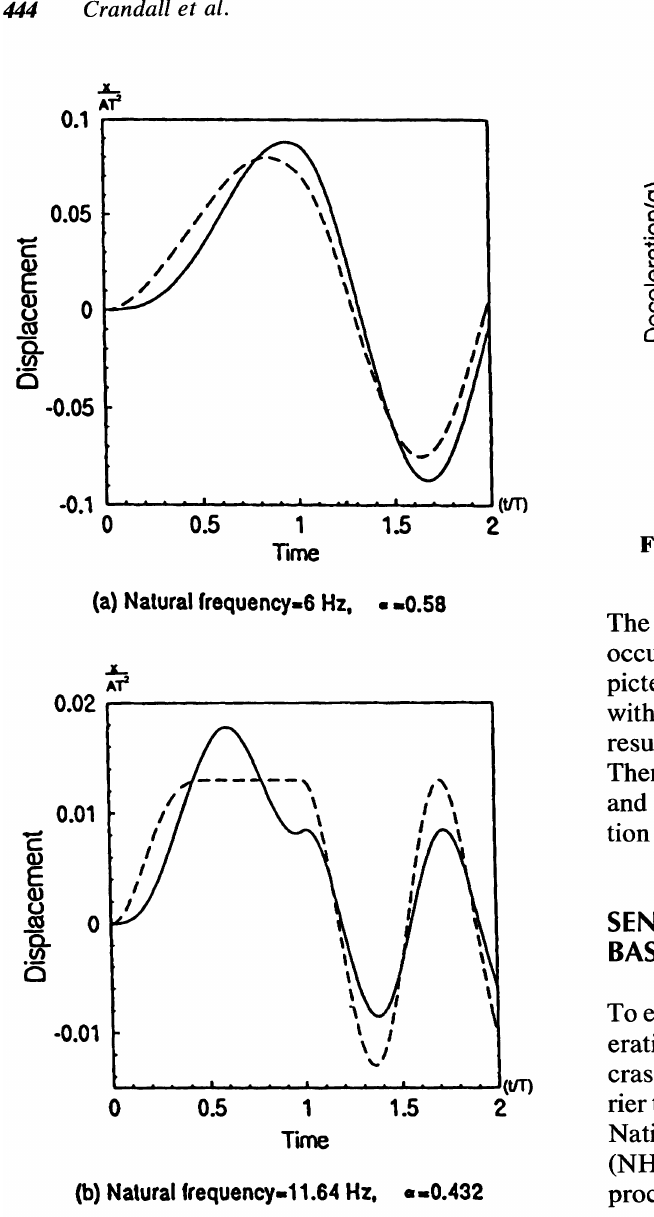
FIGURE 13 Responses of a single degree offreedom system to the pulses of Fig. 12: (a) natural frequency = 6 Hz, a = 0.58; (b) natural frequency = 11.64 Hz, a = 0.432.